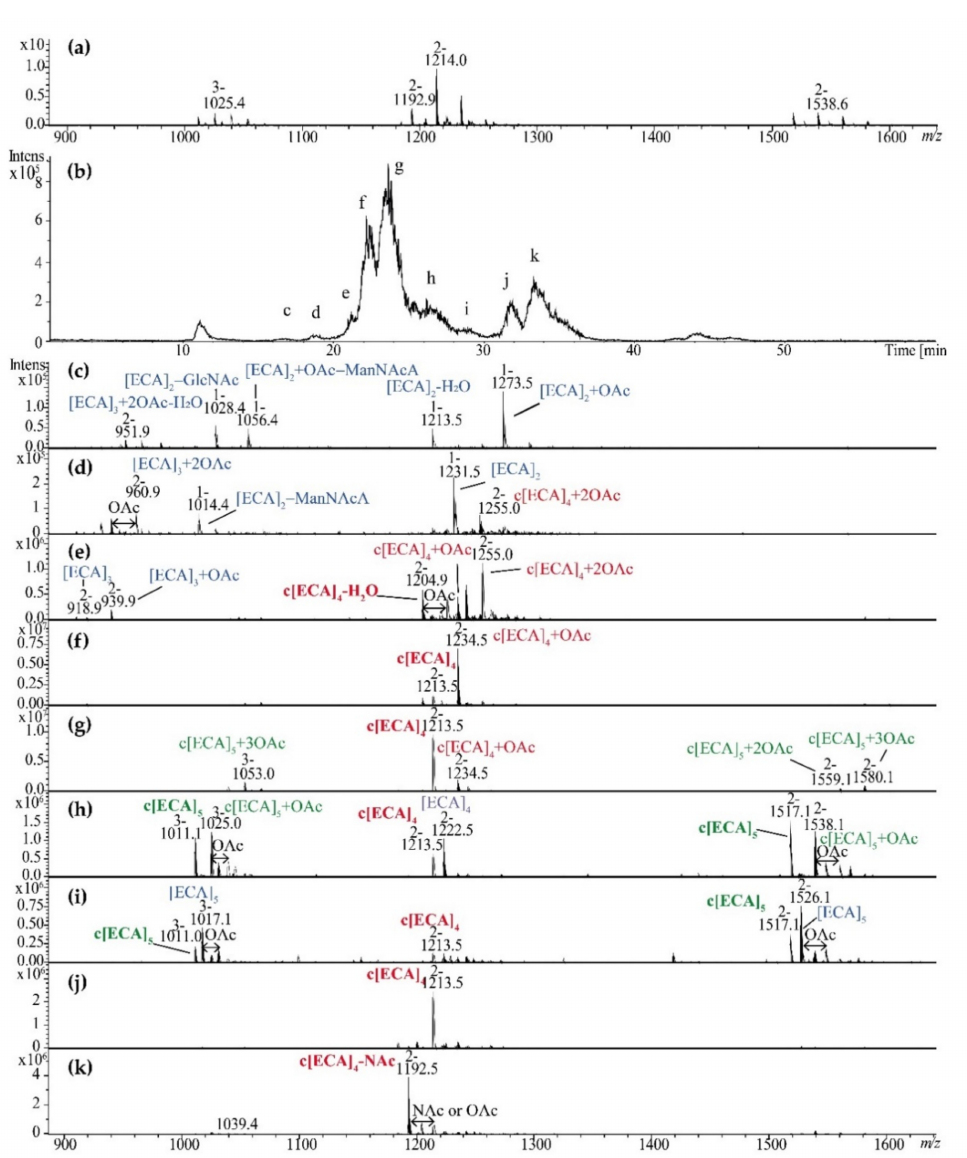
Figure 6. ZIC ® HILIC LC-MS separation of E. coli R1 c[ECA]n (pooled fraction II and III isolated by Bio-Gel P-30 fraction- ation). ( a ) Negative ion mode ESI-MS spectrum of fractions II and III (pooled). ( b ) Base peak chromatogram (BPC) for fractionation in 70–40% gradient of acetonitrile in 0.1% formic acid. ( c – k ) MS scans corresponding to fractions as it was marked in the panel ( b ). [ECA], trisaccharide repeating unit of ECA: → 3)- α -D-Fuc p 4NAc-(1 → 4)- β -D-Man p NAcA-(1 → 4)- α - D-Glc p NAc-(1 → present as constituent of linear [ECA]n or cyclic form of ECA c[ECA]n; OAc or NAc—O- or N-acetyl group; c[ECA] 4 − NAc stands for c[ECA] 4 where one of GlcNAc residues is replaced by GlcN [5,6]. Arabic numerals indicate charge of the ion. Blue, red, and green colors mark linear ECA, c[ECA] 4 + nOAc, and c[ECA] 5 + nOAc respectively, where non O -acetylated c[ECA] 5 and c[ECA] 4 is marked by bold green and red font,